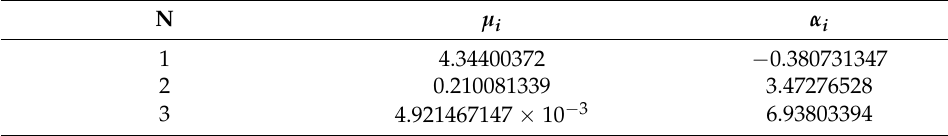
Figure 10. Stress – strain curves — experimental (red curve — test data) and numerical data fitting Figure 10. Stress–strain curves—experimental (red curve—test data) and numerical data fitting (Ogden, Arruda – Boyce, and reduced polynomial with 1 and 3 model parameters) for 90 ShA. (Ogden, Arruda–Boyce, and reduced polynomial with 1 and 3 model parameters) for 90 ShA. Table 2. Ogden model parameters for 80 ShA. Based on the performed numerical procedure, the best-fitting test was performed for the Ogden model. Obtained parameters are listed in Tables 2 and 3. Table 2. Ogden model parameters for 80 ShA.